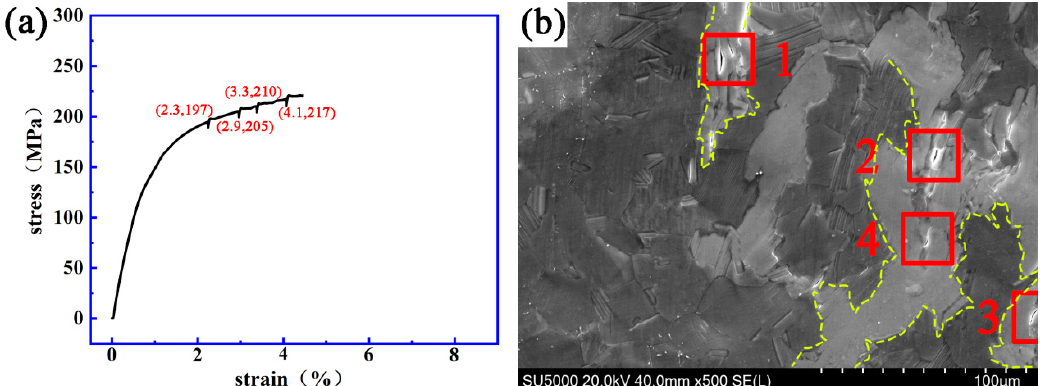
Figure 6. The dynamic change process of crack initiating and extending a Mg-13Gd-5Y-3Zn-0.3Zr alloy after solution treatment at 480 °C for 10 h. ( a ) The stress–strain curve. ( b ) The evolution process of the micro-crack.